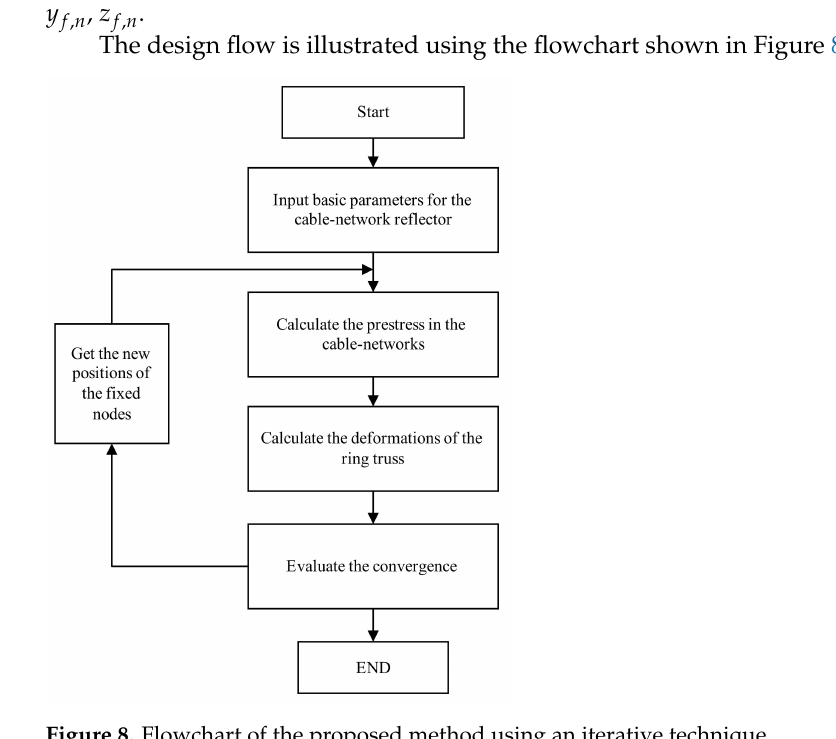
Figure 8. Flowchart of the proposed method using an iterative